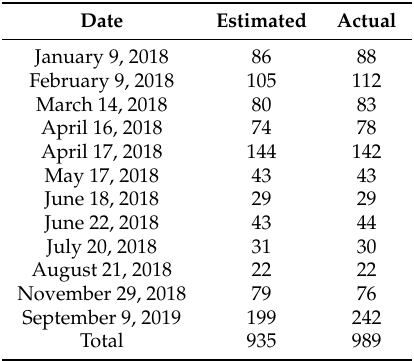
Table 4. Count estimates for the whole areas